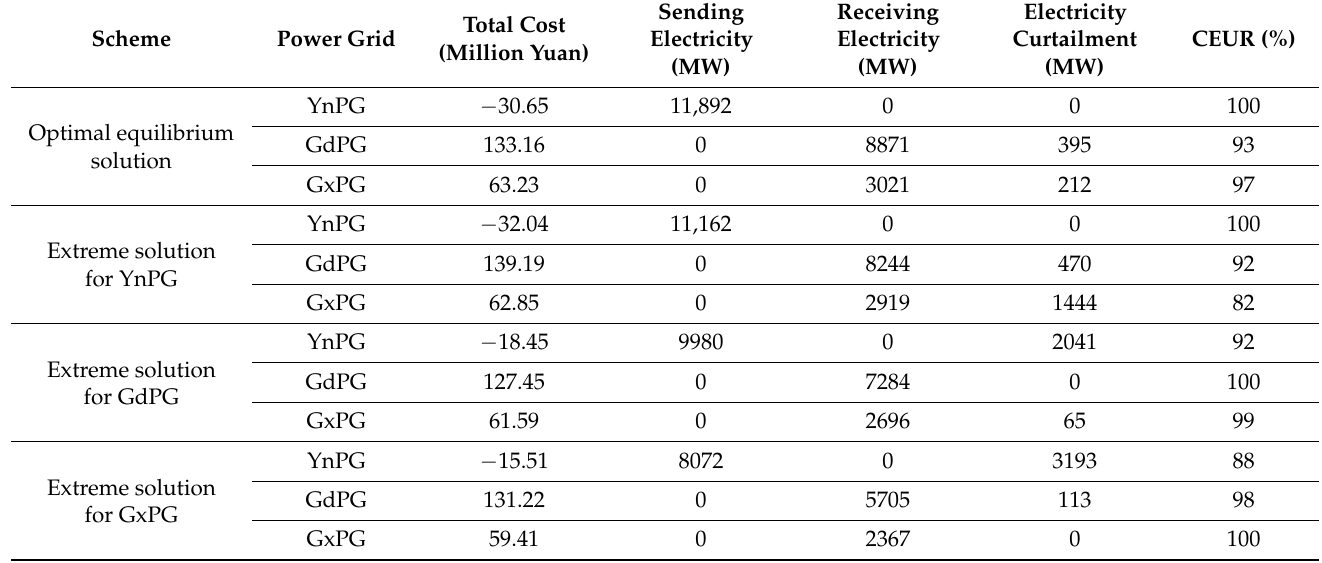
Table 3. Comparison of optimal equilibrium solution and extreme